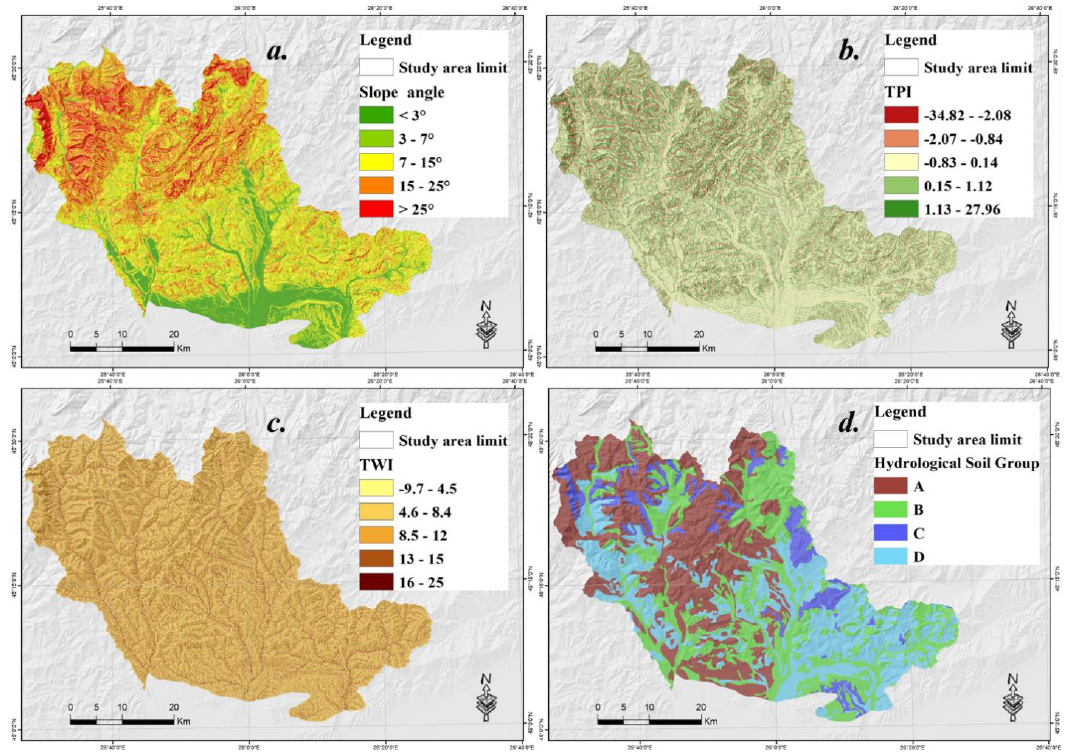
Figure 5. Flash-flood predictiors used in this research: ( a ). slope; ( b ). TPI; ( c ). TWI; ( d ). hydrological soil group.